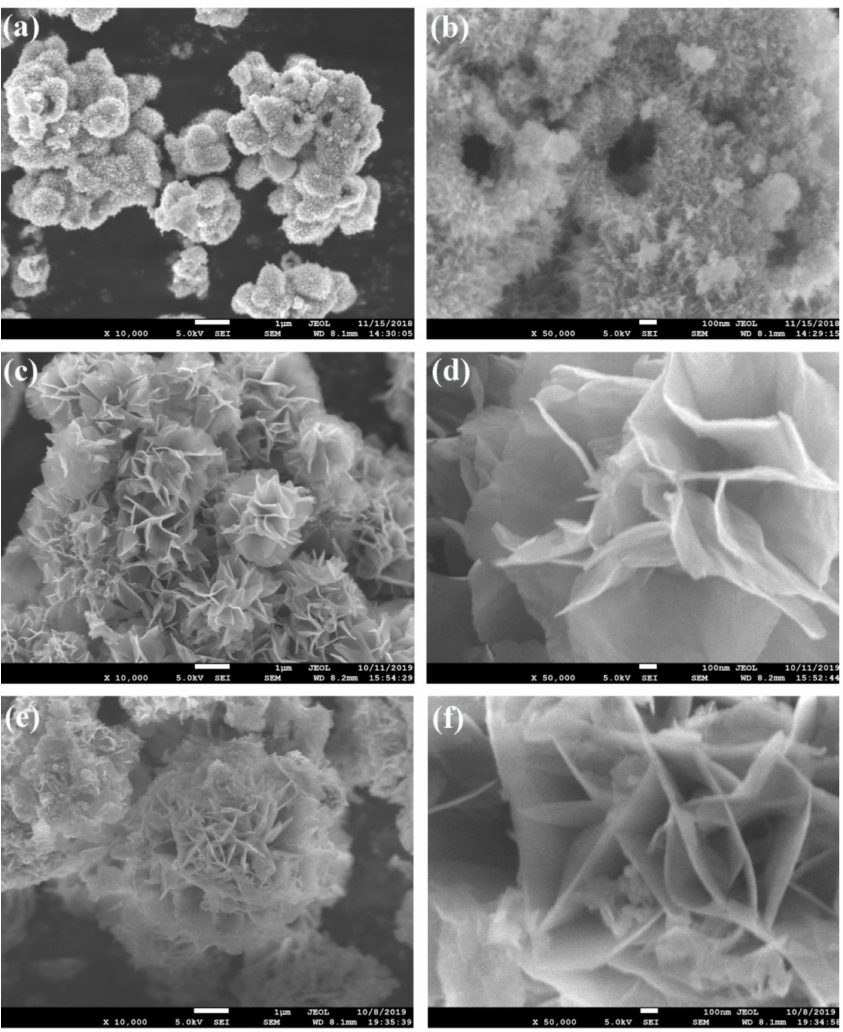
Figure 3. ( a ) Low and ( b ) high magnification SEM images of A (Co 3 O 4 electrode material